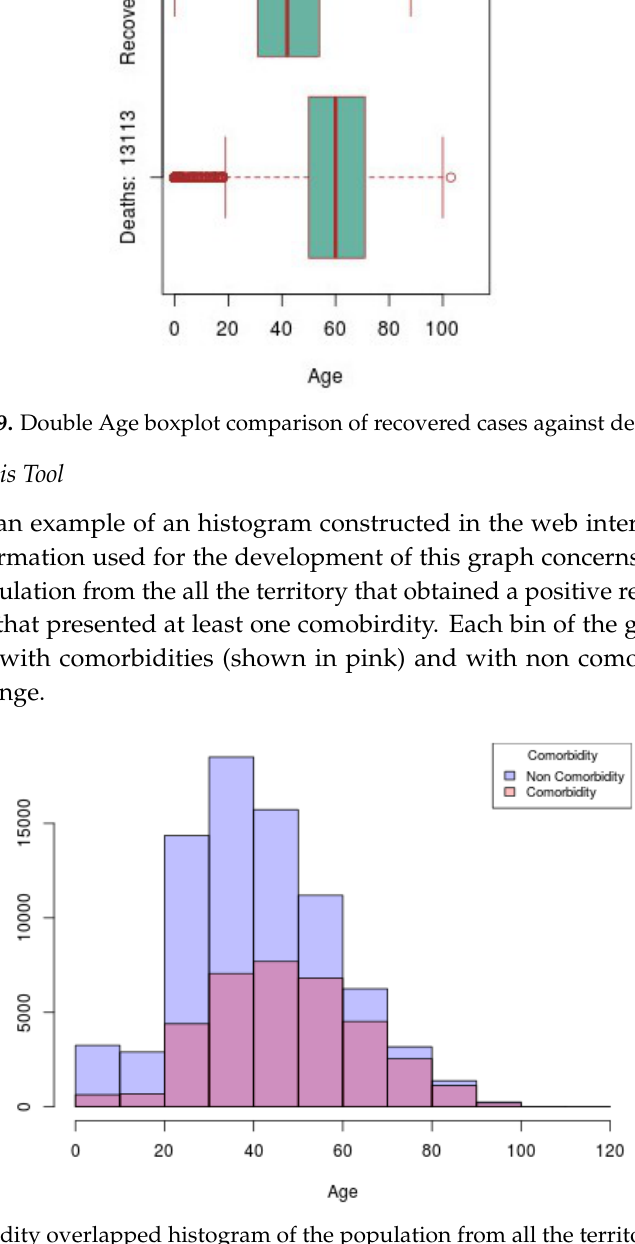
Figure 10. Comorbidity overlapped histogram of the population from all the territory with positive